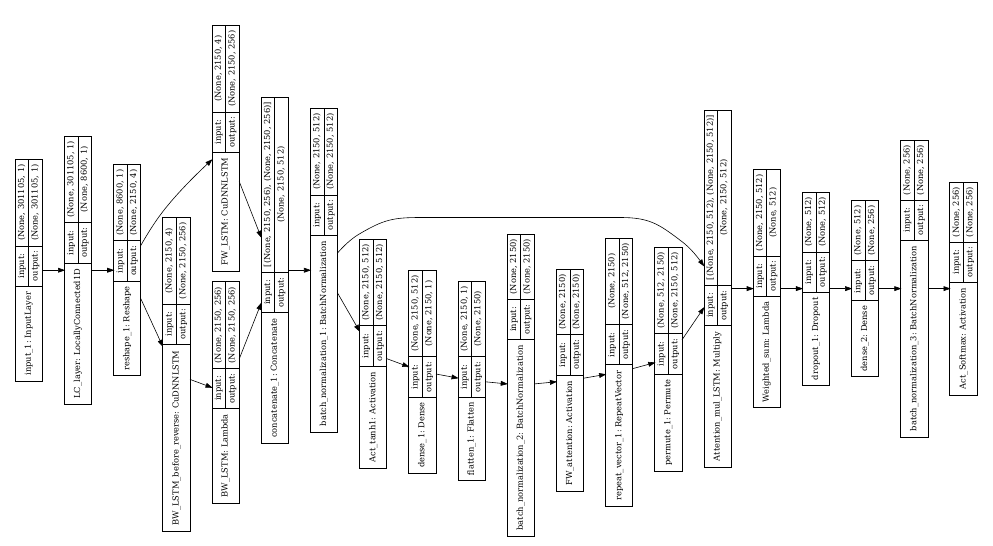
Figure 23: Network for DPA contest